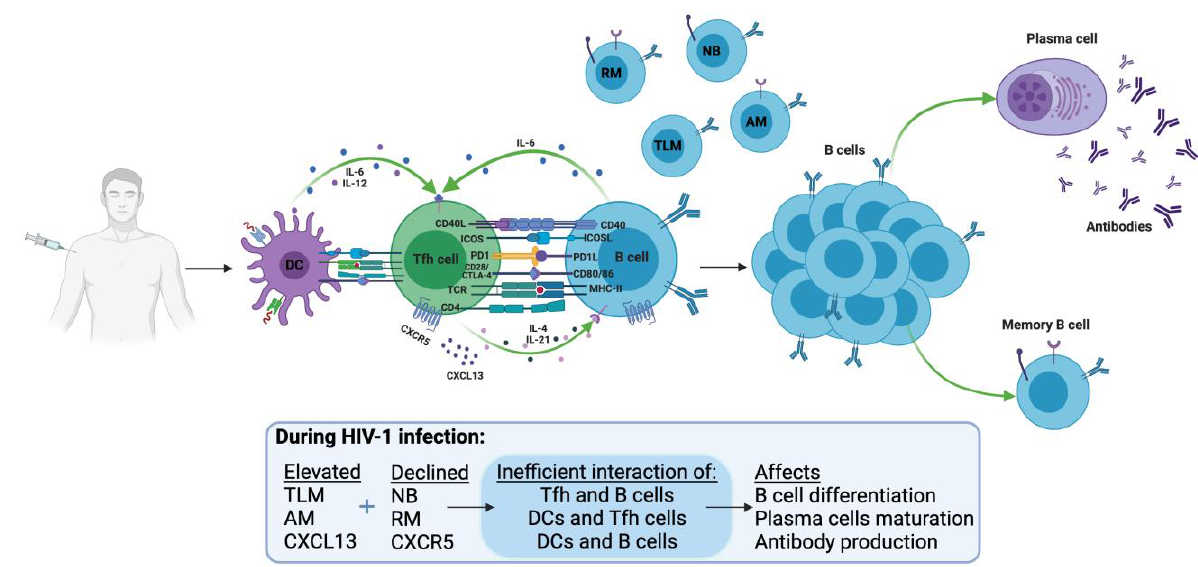
Figure 2. Immune responses to HBV vaccine. Antigen captured and processed by antigen-presenting cells (APCs); the processed antigen activates B cells and T cells. B-Tfh cells interact at the border of the GC for the generation of short-lived plasma cells and antibodies, and in the GC for the generation of long-lived plasma cells and development of memory B cells. In HIV-1 infection, inefficient interaction between B-Tfh cells was reported due to exhaustion of cells by direct and indirect effects of HIV-1. NB: naïve B cells, MB: memory B cells; AM: Activated memory B cells; TLB: Tissue-like memory B cells; Tfh: T follicular helper; IL: interleukin; GC: germinal center (Created with BioRender.com).